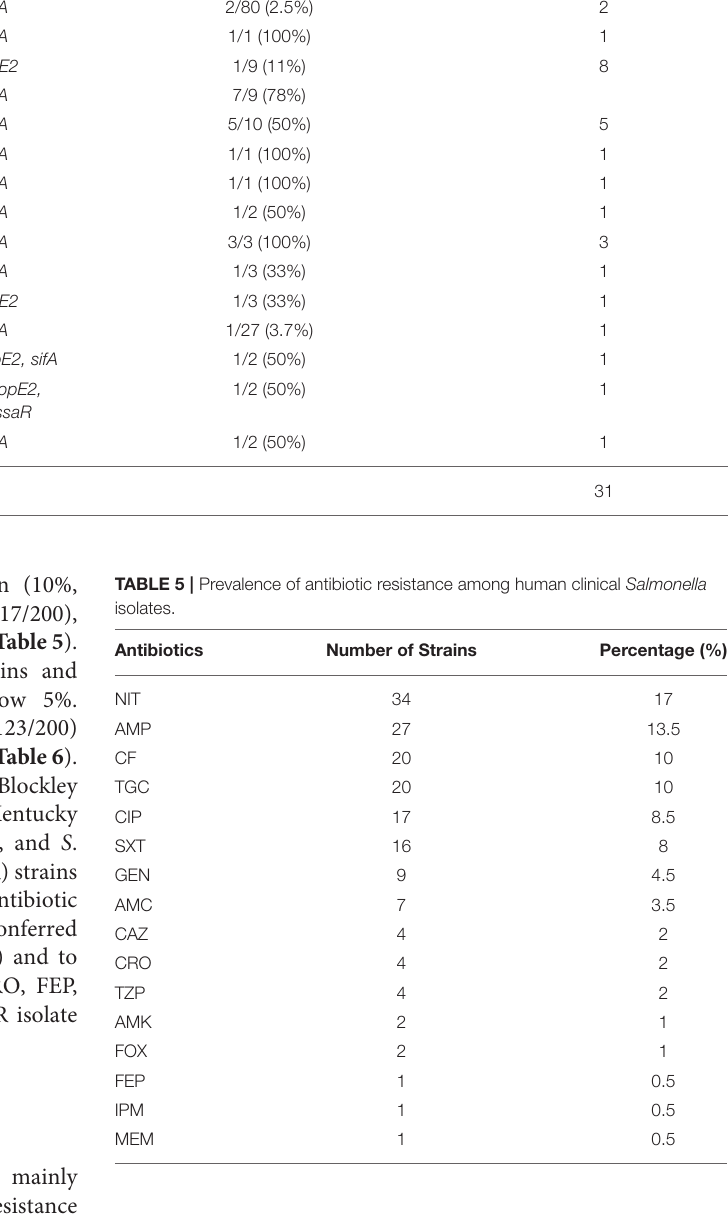
SPI genes Frequency of strains with a found absent missing SPI gene